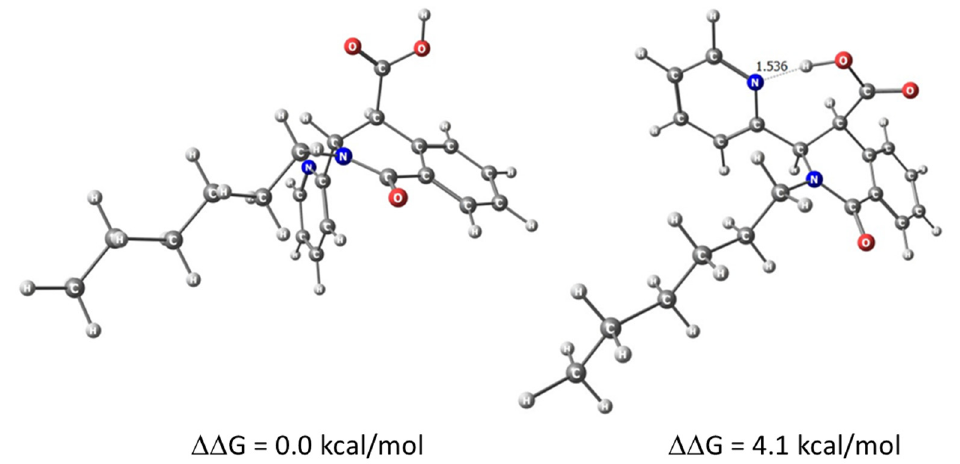
Figure 3. Optimized geometries at PCM/M06-2X/6-31 + G(d,p) level of theory (solvent dichloro- ethane) of trans -6a and cis - 6